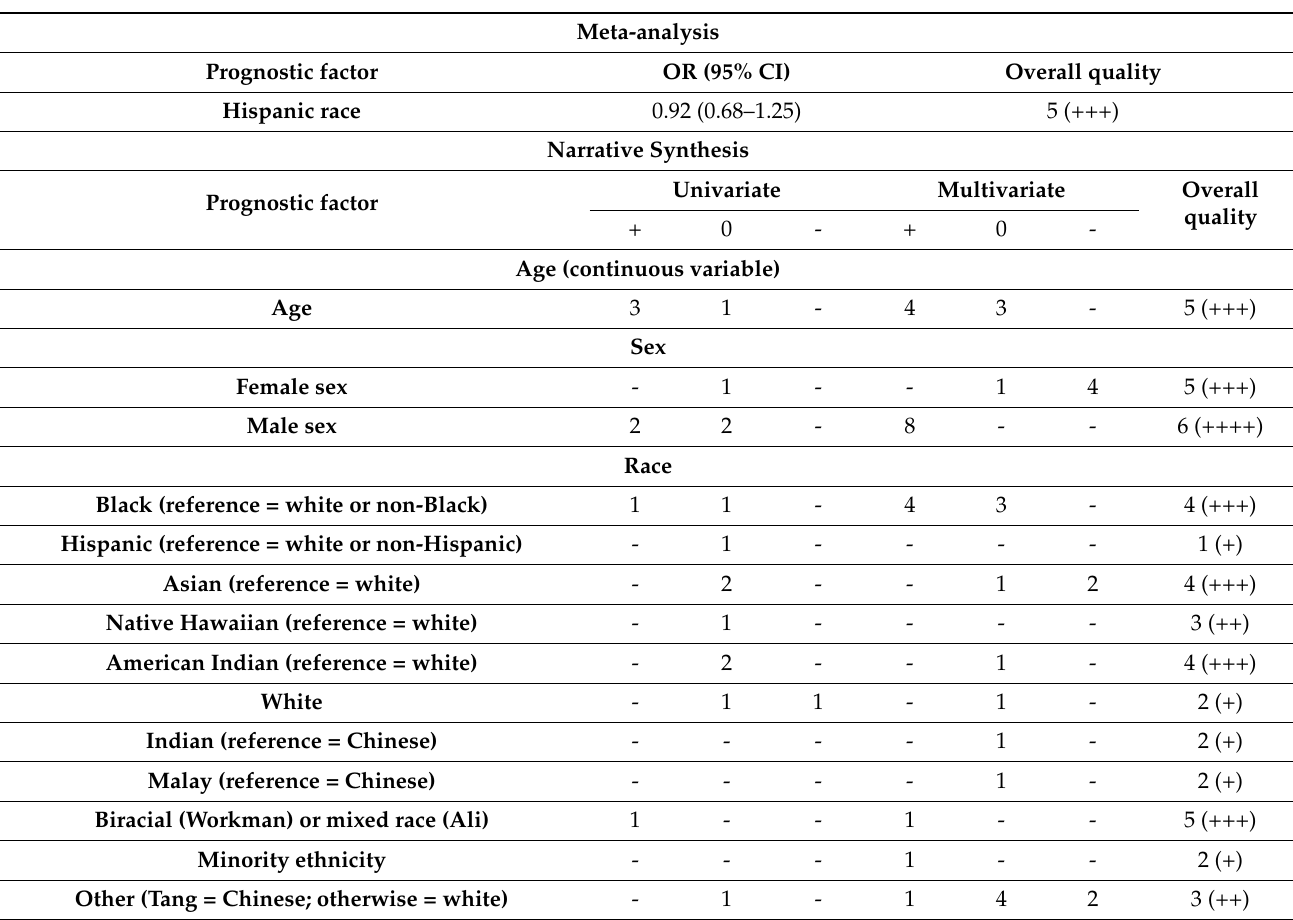
Table 5. Summary of